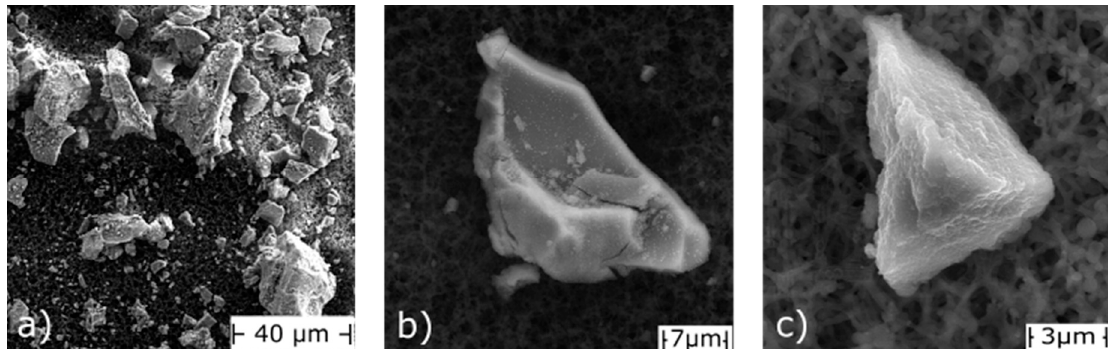
Figure 3. Scanning electron microscopic images of ( a ) unfractionated μ GFH bulk material, ( b ) an individual particle with attached fines and ( c ) a small particle deposited on a cellulose nitrate membrane.